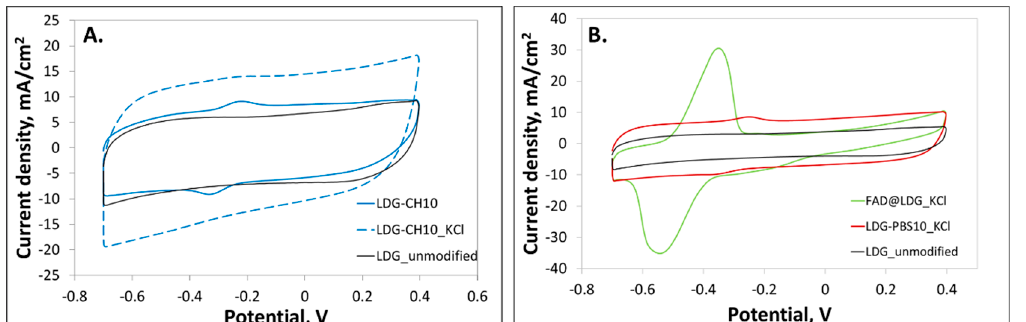
Figure 2. Bioelectrode evaluation for FAD irreversible adsorption. ( A ) chitosan-based GOx immo- bilization (solid blue line), chitosan-based GOx modified electrode treated with KCl (blue dashed line). ( B ) KCl treatment of the electrodes modified by GOx adsorption using PBS (solid red line) and FAD direct adsorption (solid green line). Unmodified LDG electrodes (solid black line). All the volt- ammograms were acquired at 0.2 V/s in O 2 free atmosphere.